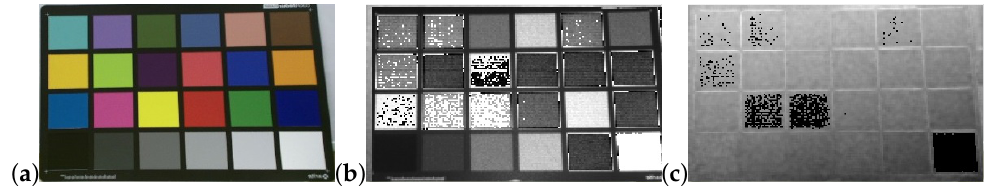
Figure 4. The effect of color in Kinect V2 camera. ( a ) RGB image. ( b ) IR image. ( c ) Depth